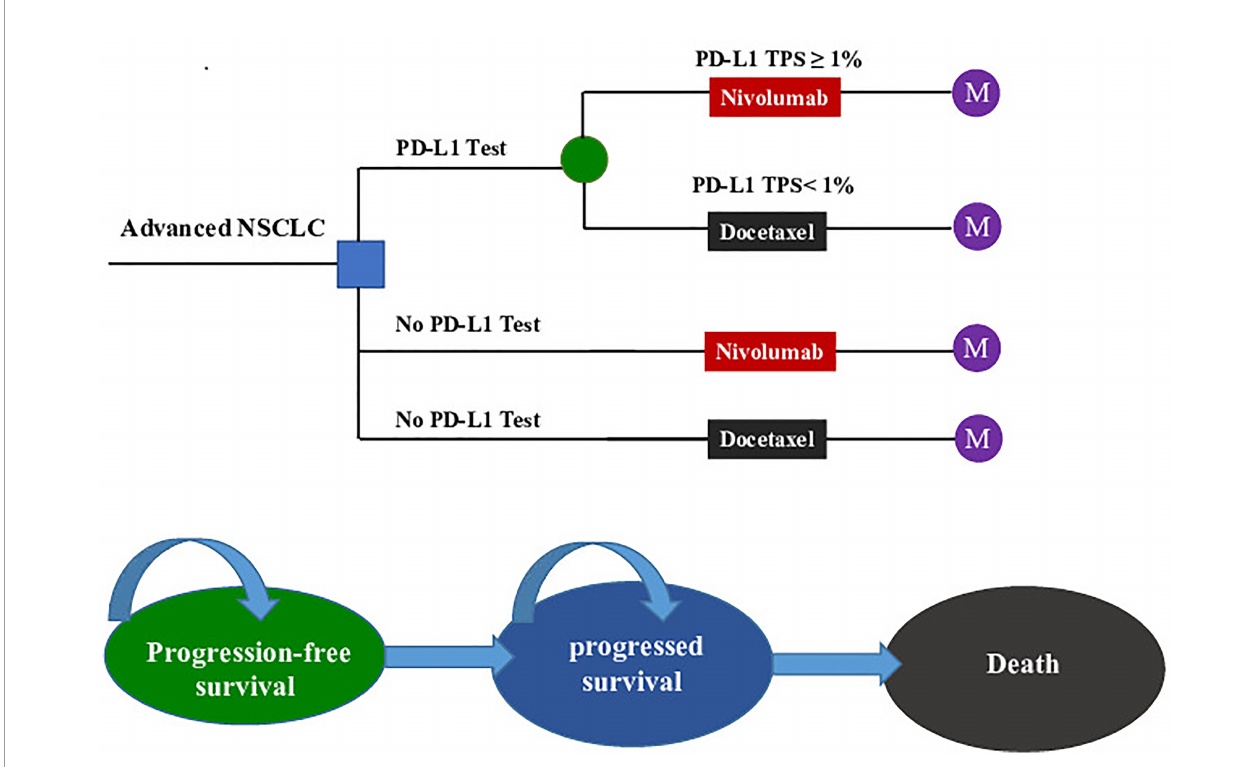
FIGURE 1 | The Markov state transition model. NSCLC, non-small cell lung cancer; PD-L1, programmed death ligand 1; TPS, tumor proportion score; M, Markov